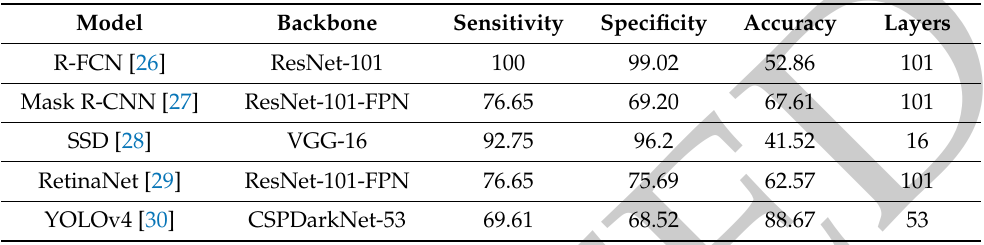
Table 8. Performance of object detection models on BDD100K